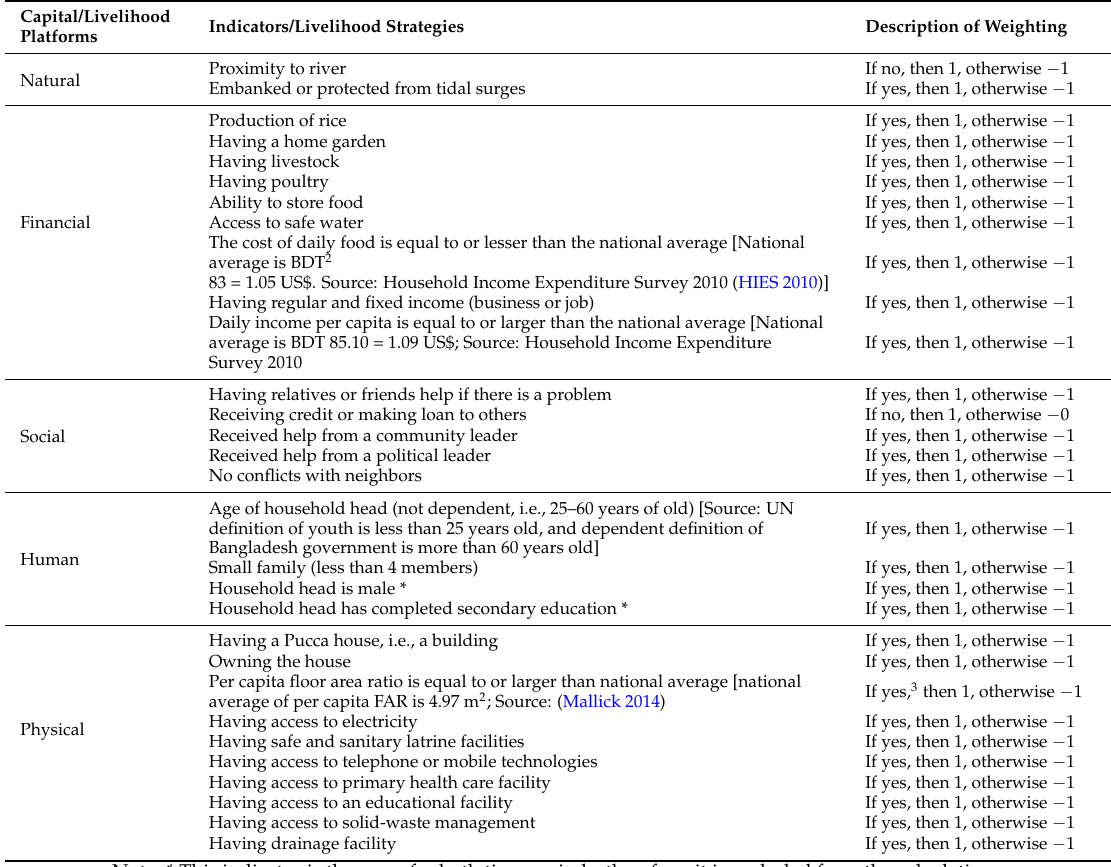
Table 3. Factors included in indexing livelihood